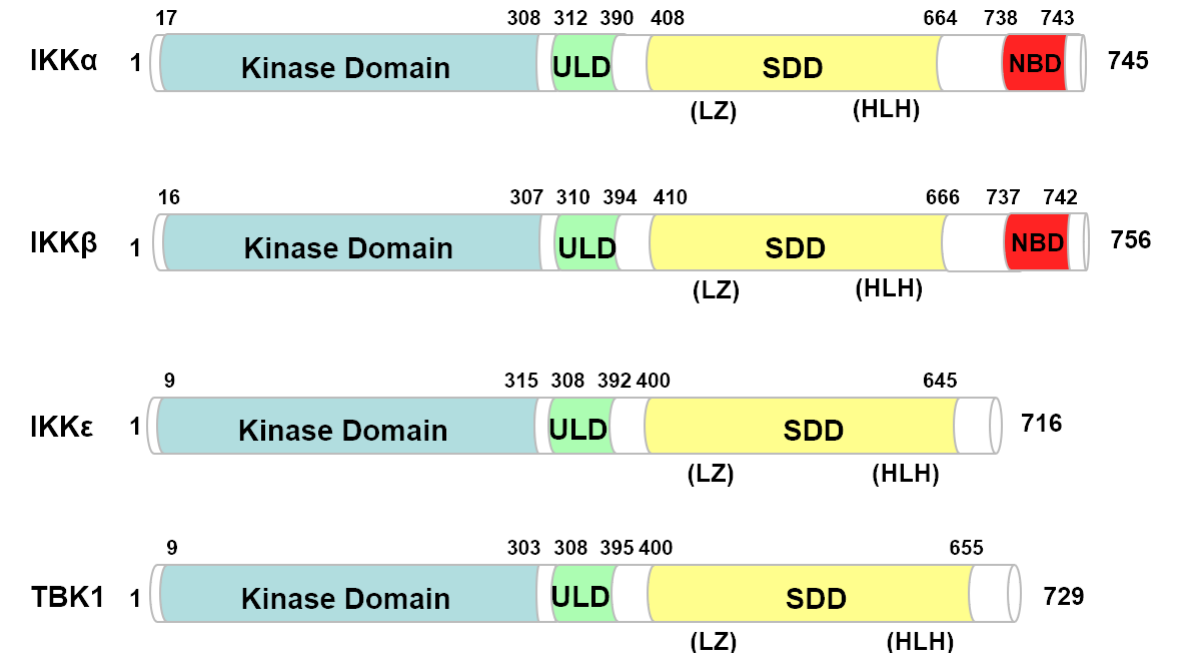
Figure 1. The structural comparison of the IKK family members. The principal structural motifs of the four members of IκB kinase (IKK) family are shown, together with amino acid numbers corresponding to the human proteins. ULD, ubiquitin-like domain; SDD, scaffold dimerization domain; LZ, leucine-zipper; HLH, helix-loop-helix; NBD, NEMO-binding